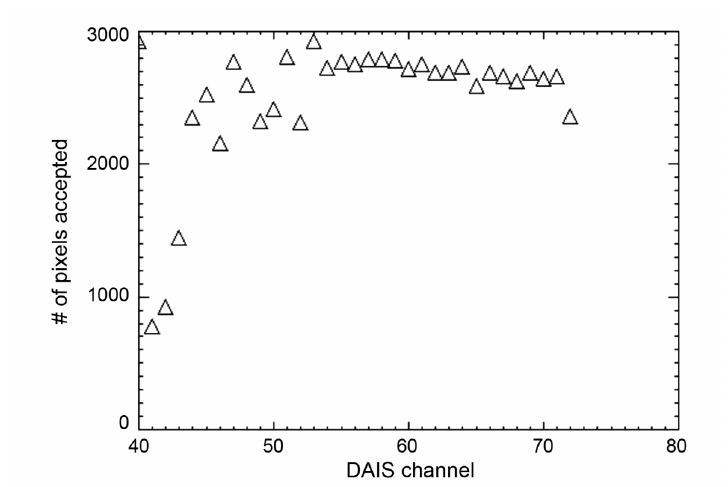
Fig. 8. Histogram of the number of pixels where the DB algorithm does give solutions and pixels are accepted by the chosen selection